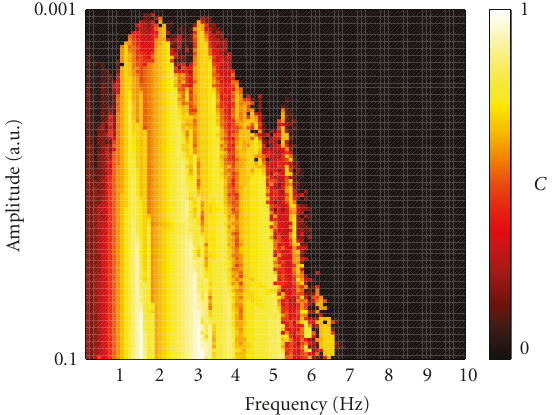
Figure 1: Spike rate C in the last unit of a medium composed of L = 3 FHN units. The first unit was perturbed with sine waves of varying amplitudes and frequencies. The time scaling coe ffi cient (cid:2) was set to 10 and time series consisted of N = 5000 data